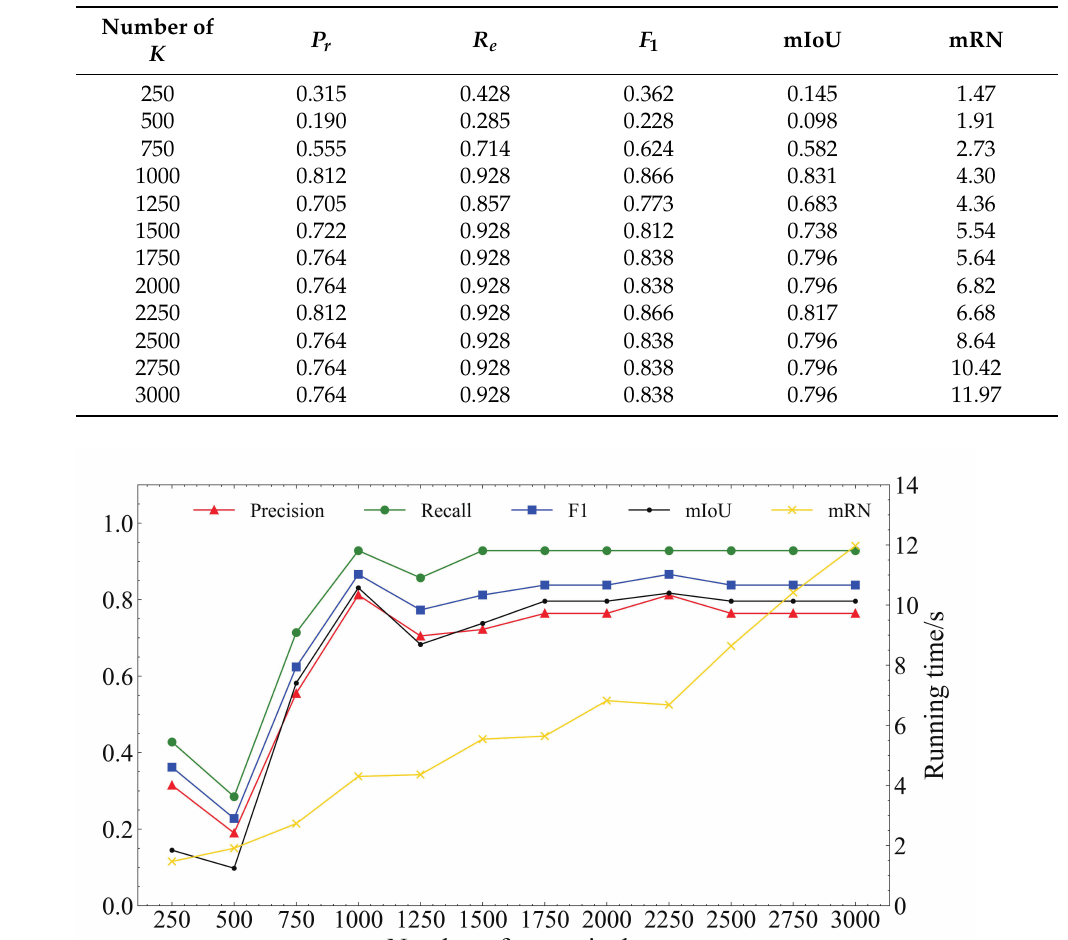
Table 4. Detection performance for different numbers of K .